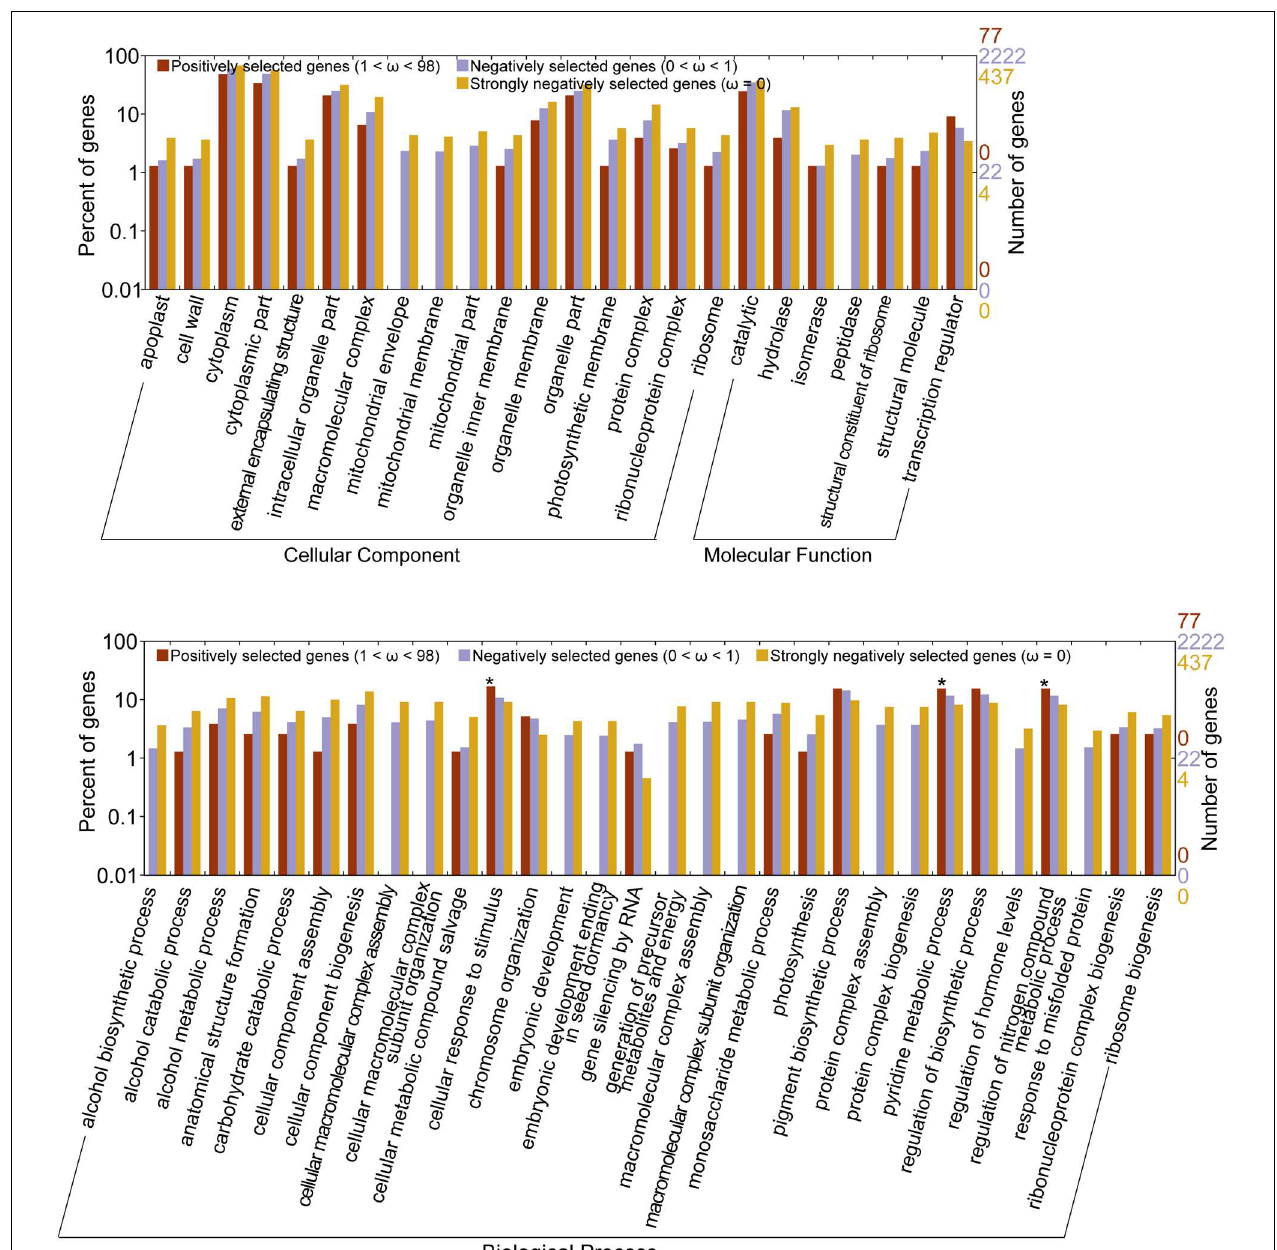
FIGURE 3 | Gene Ontology (GO) distribution plotted by WEGO. Only the GO with significantly different level ( p -value of Pearson Chi-Square test < 0.05) were shown. ∗ indicates the GOs over-represented in positively selected genes. The original data for plotting this figure was provided in Supplementary